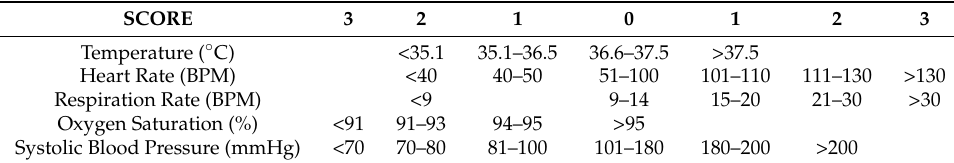
Table 2. Early warning score system based on Ziekenhuis Oost-Limburg (ZOL)